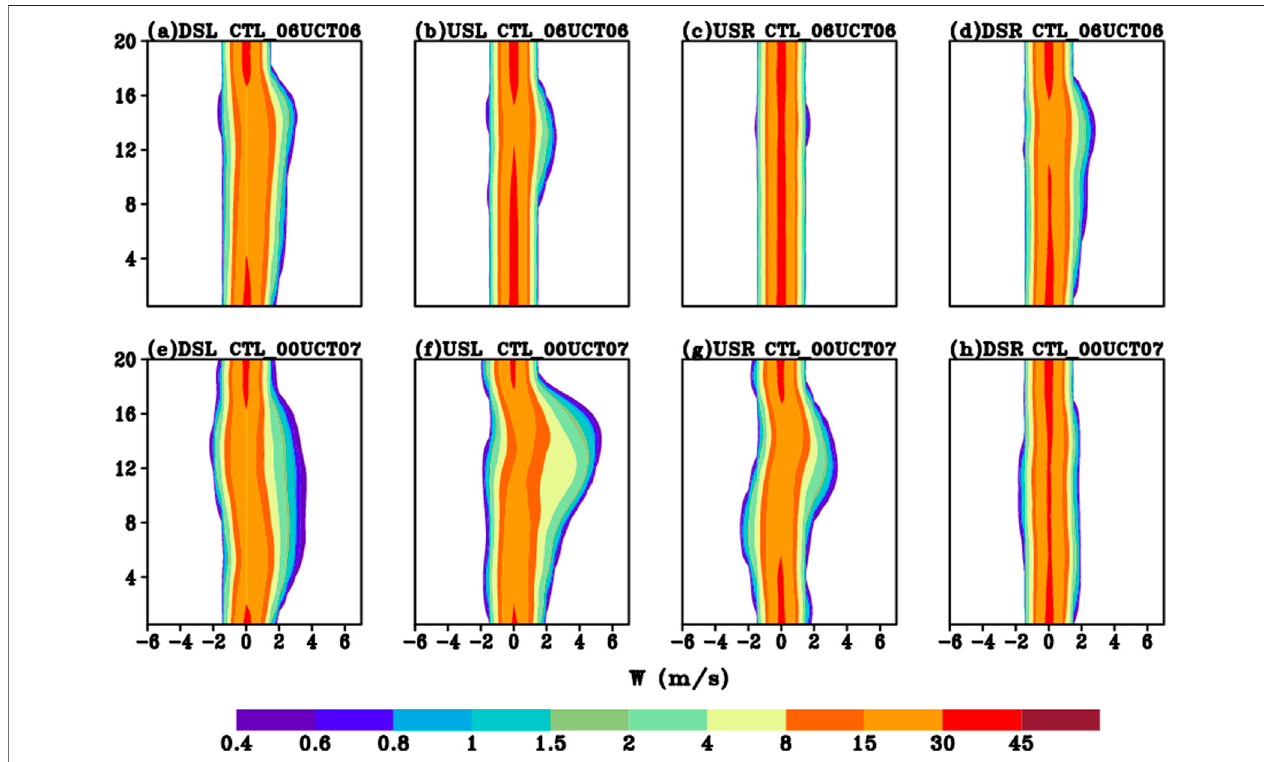
FIGURE 5 | Snapshots of 06 UTC 06 and 00 UTC 07 August of the contoured frequency by altitude diagrams (CFADs) of vertical velocity separated according to shear quadrant (units: %). With the shear vector pointing left, the quadrants are (A, E) DSL, (B, F) USL, (C, G) USR, (D, H) DSR in CTL.